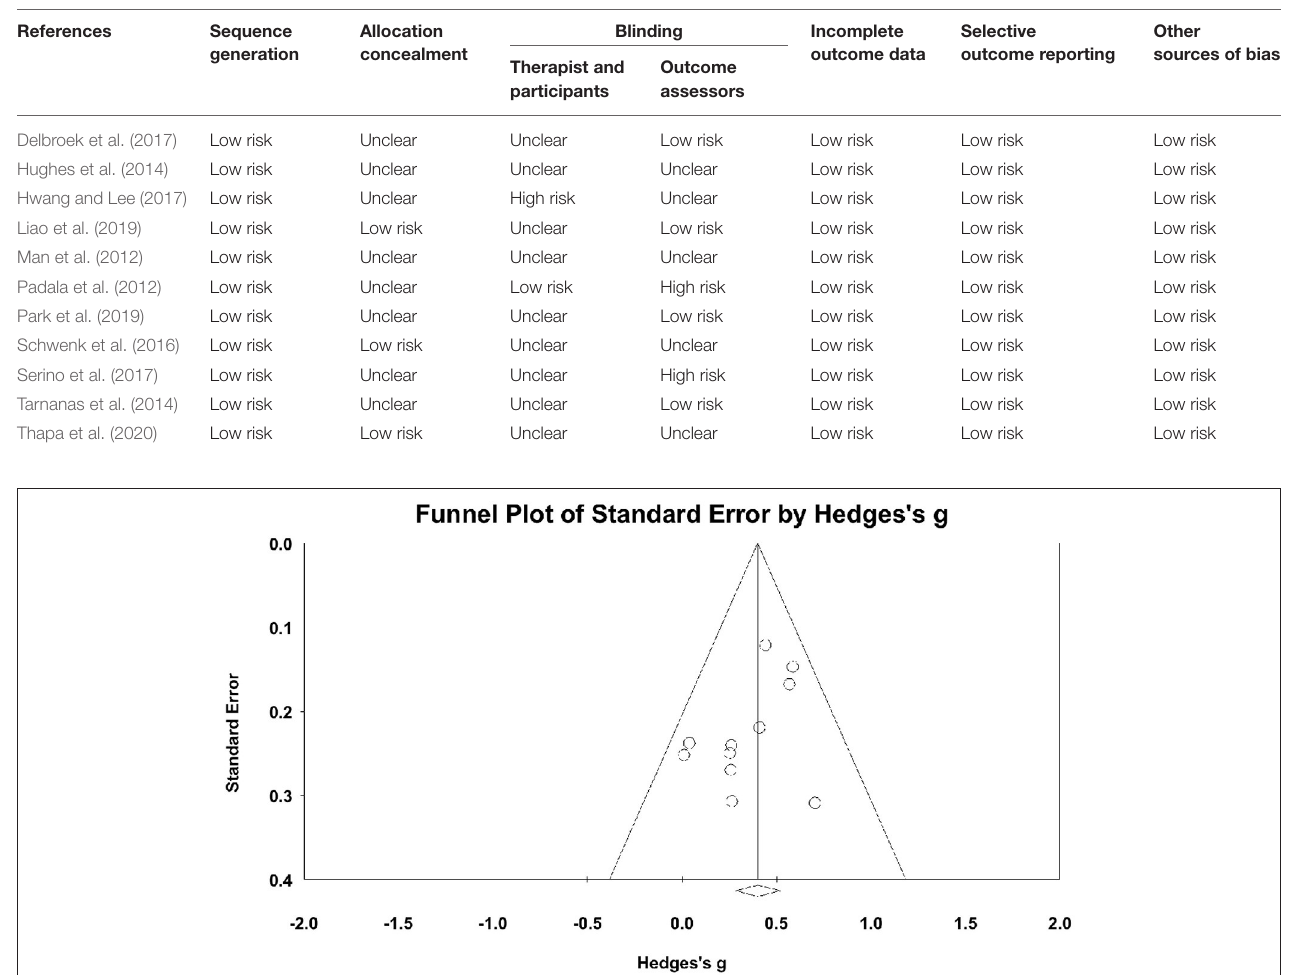
TABLE 6 | Risk of bias assessment in included studies: the authors’ judgments on each risk of bias item for all included studies.